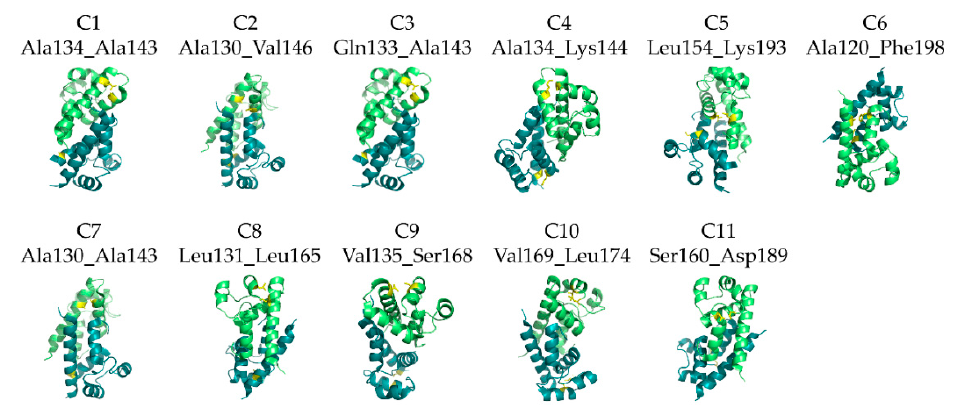
Figure 2. Cartoon diagrams of proposed hCD81 LEL mutants with pairs of amino acids mutated to cysteine indicated in yellow. Green: protomer A; teal: protomer B. Figure was prepared with PyMOL (PyMOL Molecular Graphics System, Version 1.3 Schrödinger, LLC).